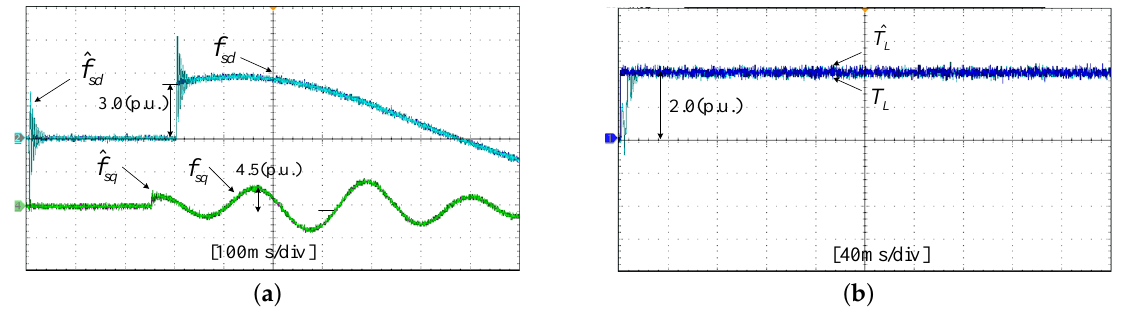
Figure 30. Experimental results of high and low frequency sensor faults, unknown load and their estimated values. ( a ) Sensor faults f d , f q and their estimated values ˆ f d , ˆ f q ; ( b ) unknown load T L and its estimated value ˆ T L